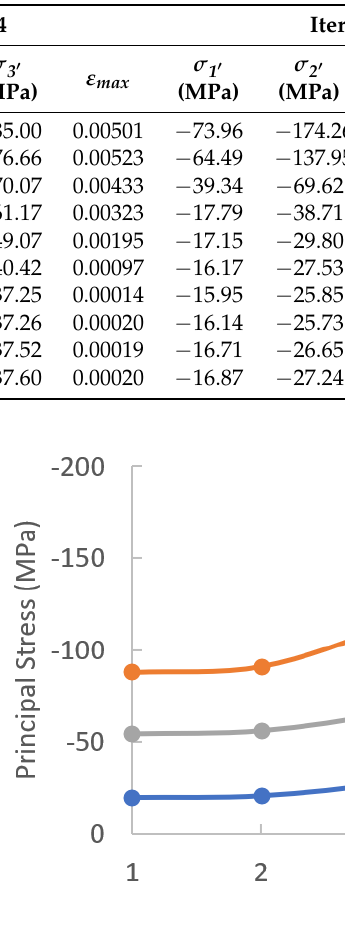
Figure 7. Principal stresses for the element in the breakout tip in the process of breakouts.